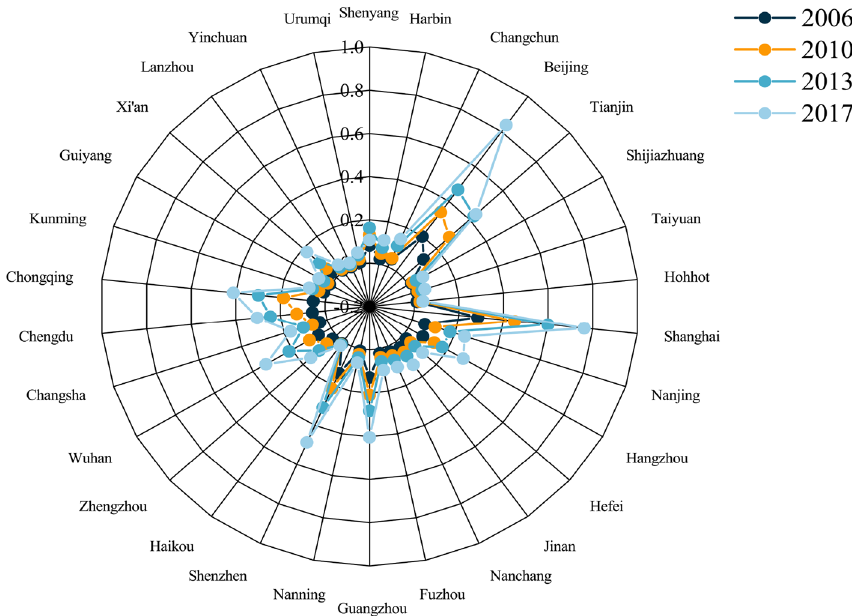
Figure 4. Trend of the economic index in typical cities in